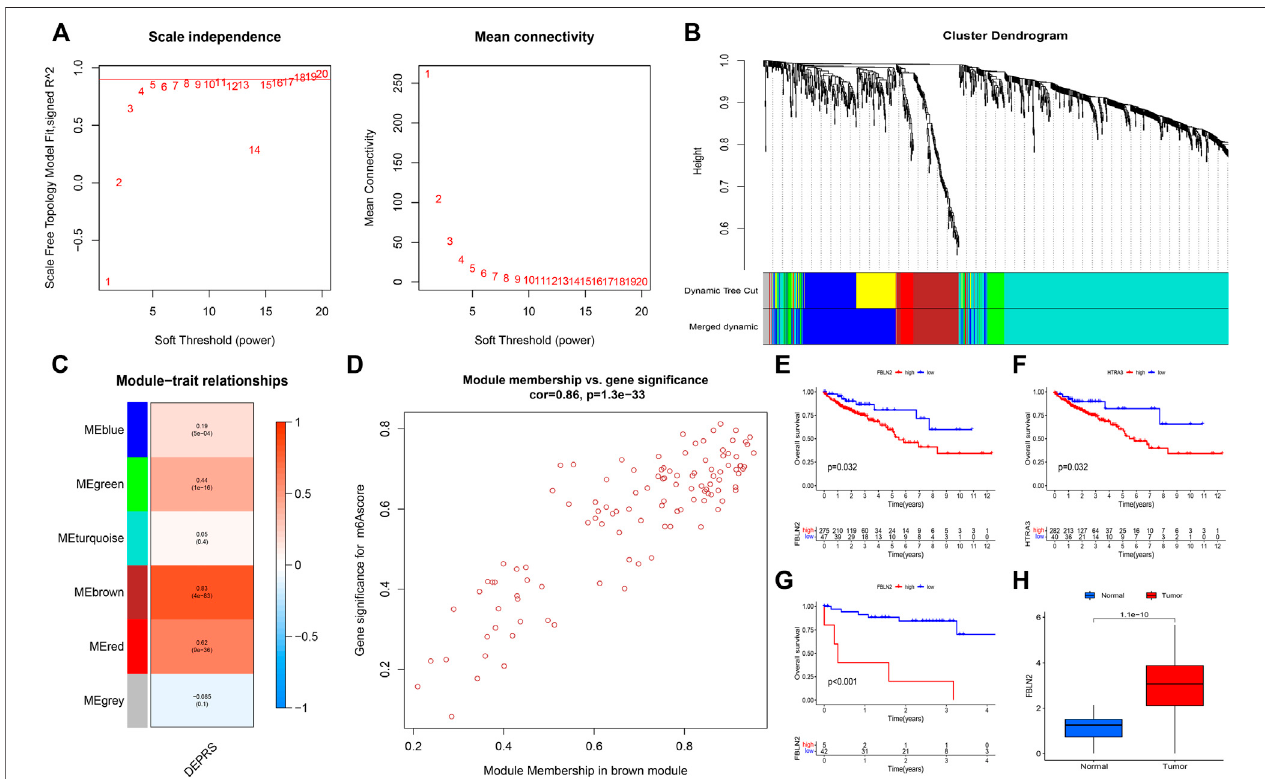
FIGURE 9 | (A) To achieve a scale-free co-expression network, the power index = 5 was chosen as the appropriate soft threshold. (B) The branches of the dendrogram correspond tosixdifferent genemodules. (C) The correlation between gene modules and DEPRS. Each cellcontainscorresponding correlation coef fi cient and p -value. (D) Signi fi cantpositivecorrelationbetweenmodulemembershipandgenesigni fi cance(Correlationcoef fi cient=0.86, p < 0.001). (E,F) Kaplan-Meiercurves showing the overall survival of the two key genes FBLN2 ( p = 0.032) (E) and HTRA3 ( p = 0.032) (F) . Red represents high expression, and blue represents low expression. (G) The difference in OS between high and low FBLN2 expression groups ( p < 0.001). (H) The difference in FBLN2 expression between cancer tissues and normal tissues at protein